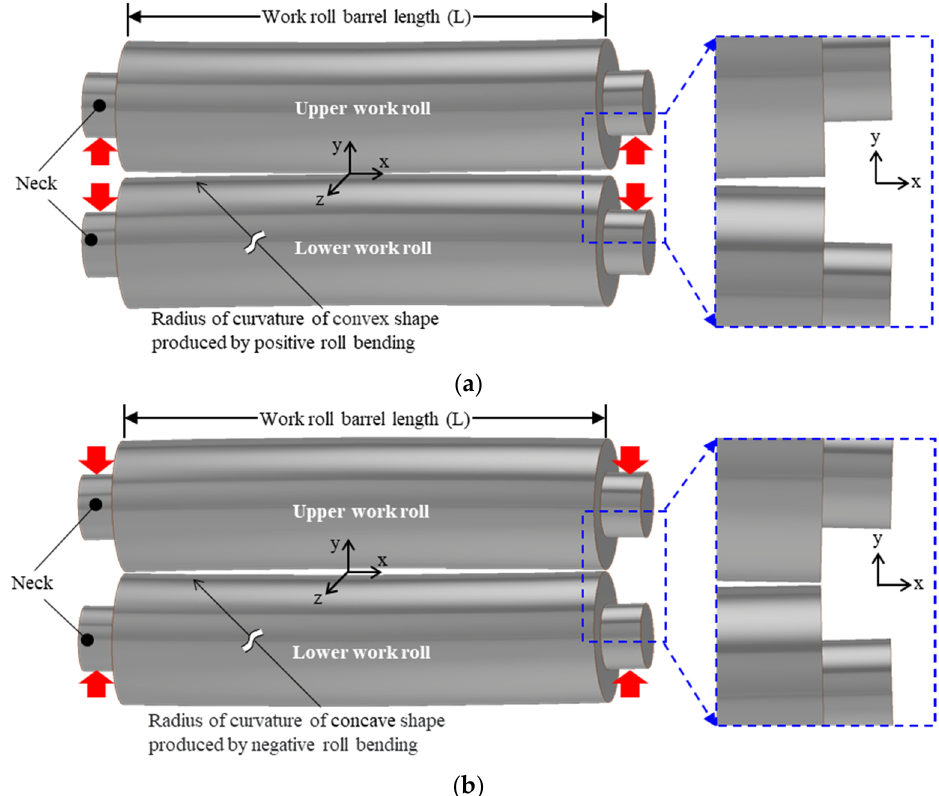
Figure 2. Schematic of two types of roll bending. ( a ) Positive roll bending ( b ) Negative roll bending.